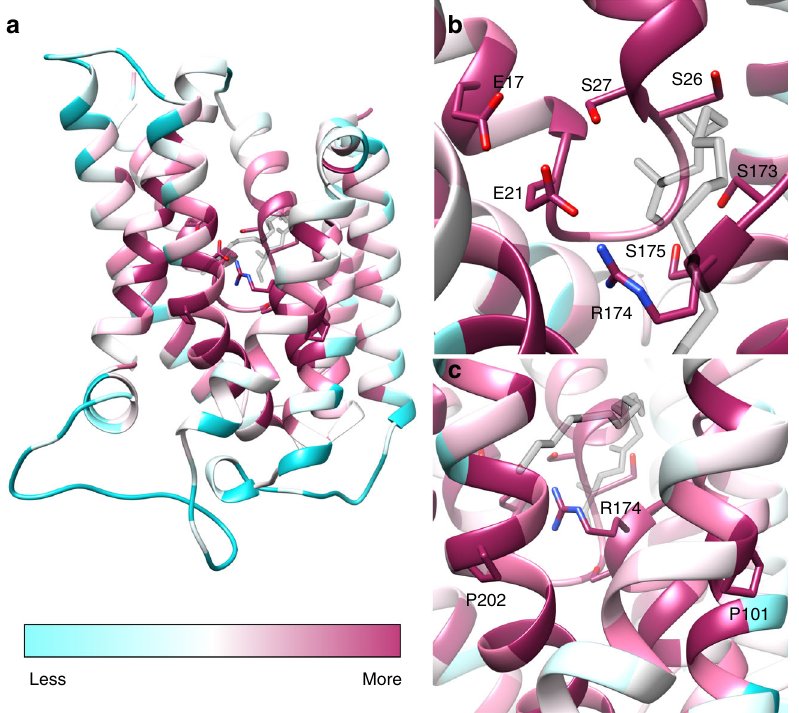
Fig. 3 Conservation of Ec UppP catalytic core. a Ec UppP structure colored according to sequence conservation from low (cyan) to high (maroon). Highly conserved residues cluster near the catalytic core of the protein. Monoolein displayed in transparent gray. b Top-down view of the active site, showing the highly conserved nature of residues implicated in catalysis (E17, E21, S27, and R174) and maintenance of the reentrant loop architecture (S26, S173, and S175). c Magni fi cation of strictly conserved proline residues that facilitate the bending of α 4a and α 8 to create the cleft that gives access to the active